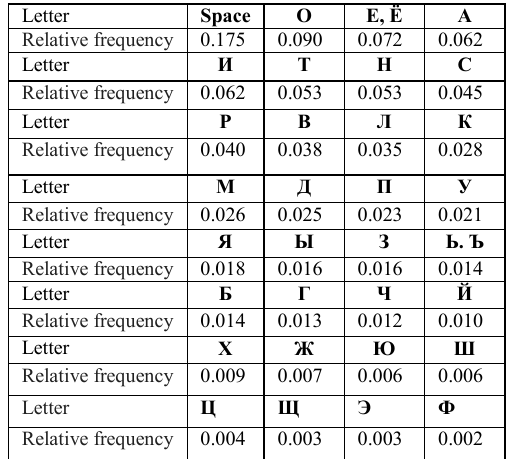
Table 1. The probability of the appearance of symbols for texts in